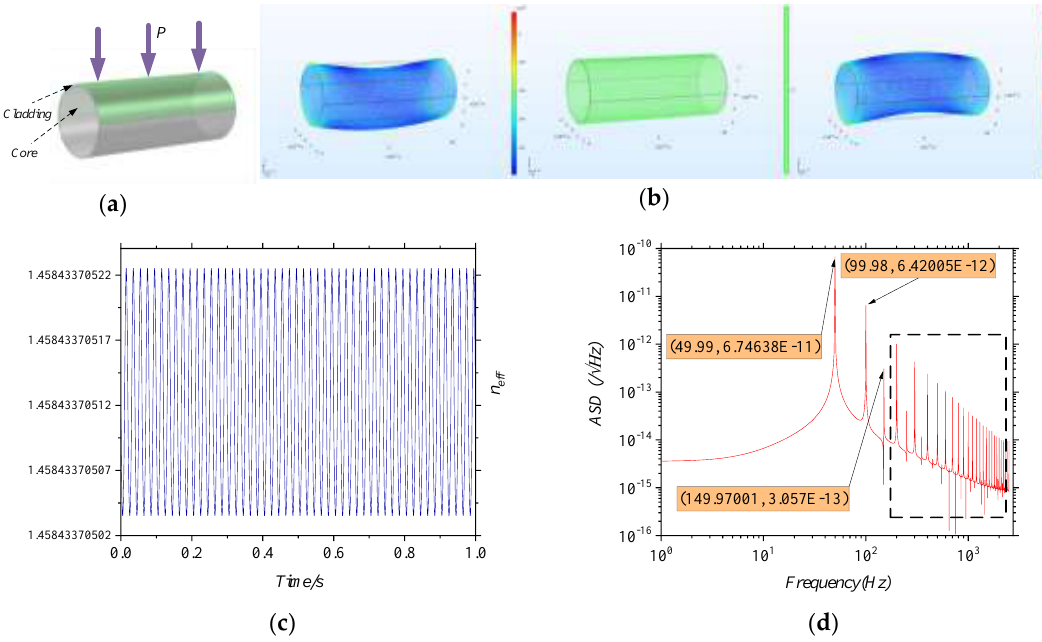
Figure 2. ( a ) The COMSOL model of multimode fibers (MMFs) with load P applied to the upper surface of the cladding; ( b ) The figures of the MMF’s deformation and stress distributions under the load at t = 2 ms, t = 10 ms, and t = 12 ms; ( c ) The graph of the effective refractive index (ERI) of the fundamental mode; ( d ) The graph of the amplitude spectral density of the ERI.